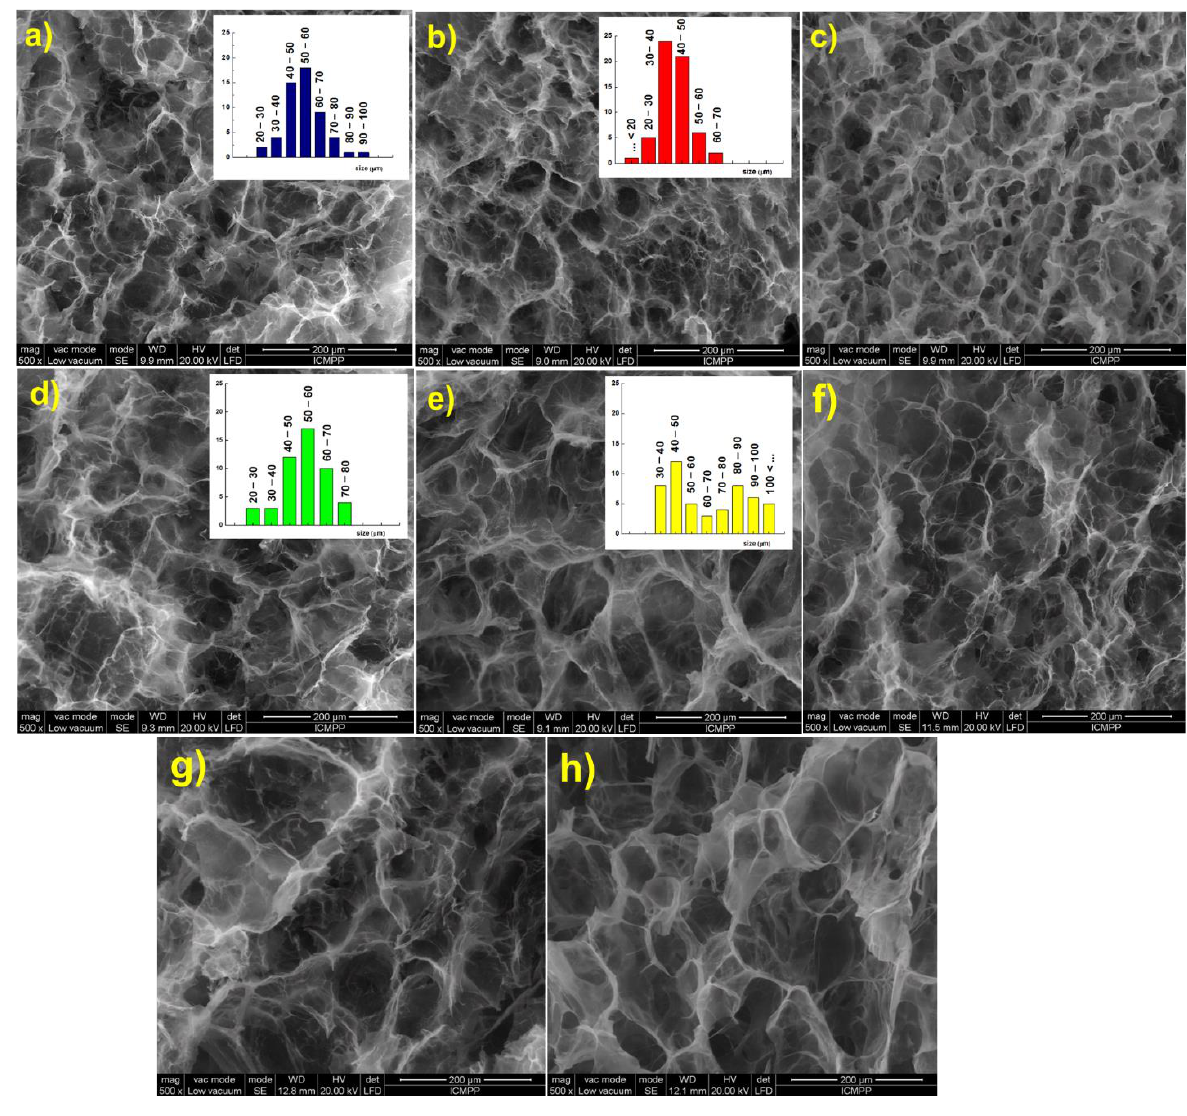
Figure 3. Scanning electron micrographs of the CS/PVA hydrogels in cross section: ( a ) CS 1 /PVA 1 E 1 (24); ( b ) CS 1 /PVA 1 E 2 (24); Scanning electron micrographs of the CS/PVA hydrogels in cross ( c ) CS 1 /PVA 1 E 2 (48); ( d ) CS 1 /PVA 1 B 1 (24); ( e ) CS 1 /PVA 1 B 2 (24); ( f ) CS 1 /PVA 1 B 2 (48); ( g ) CS 0.5 /PVA 1 E 2 (24); ( h ) CS 1 /PVA 0.5 E 2 (24).